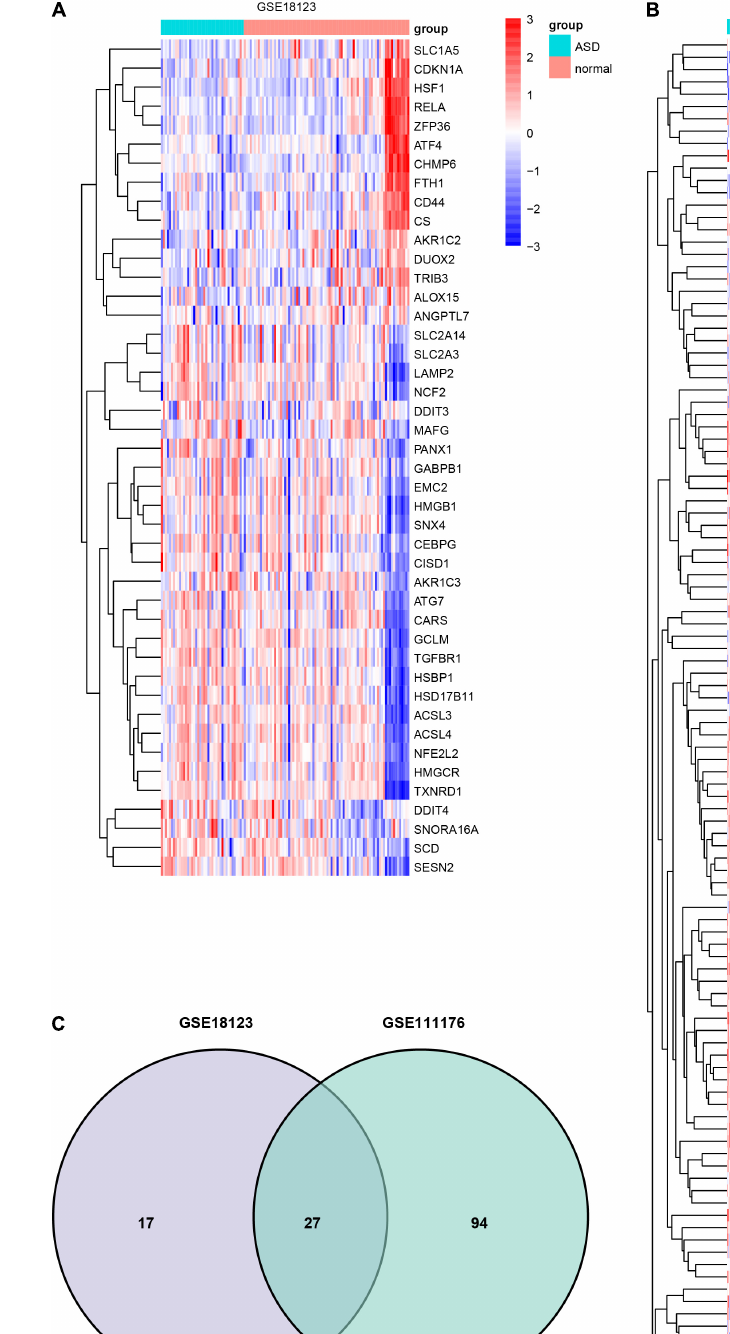
Frontiers in Psychiatry |